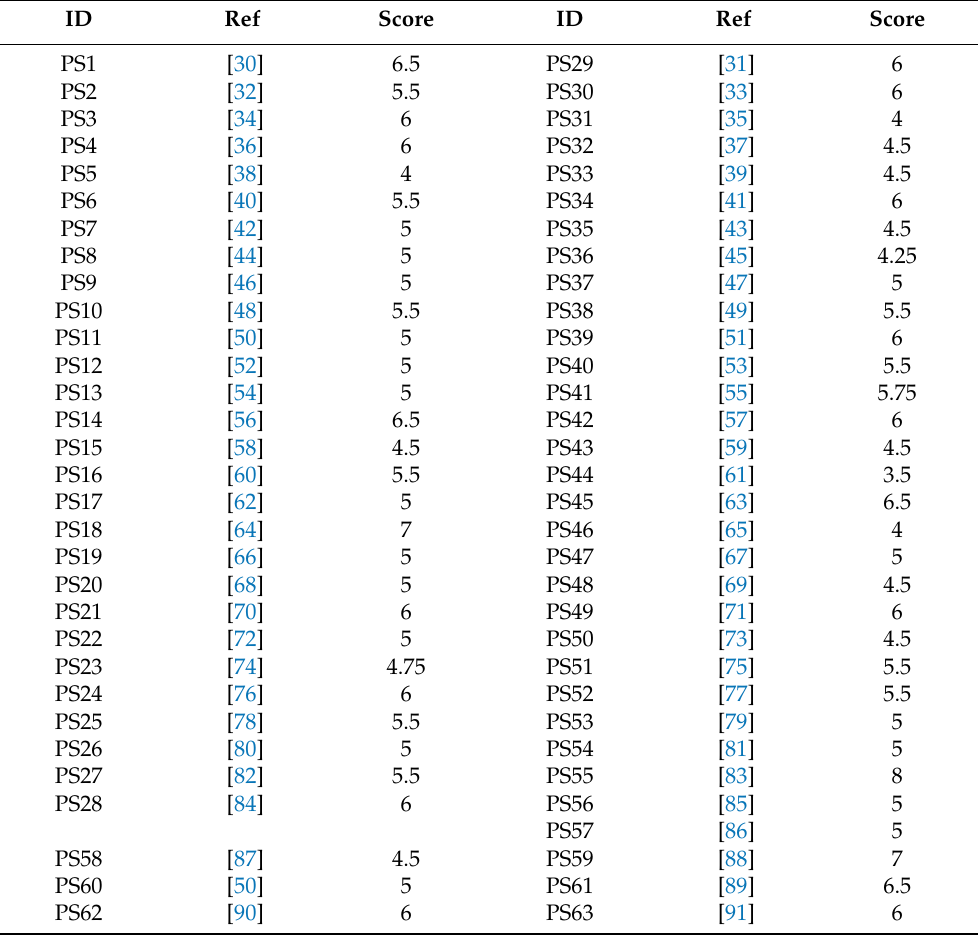
Table 3. Quality assurance scores of selected